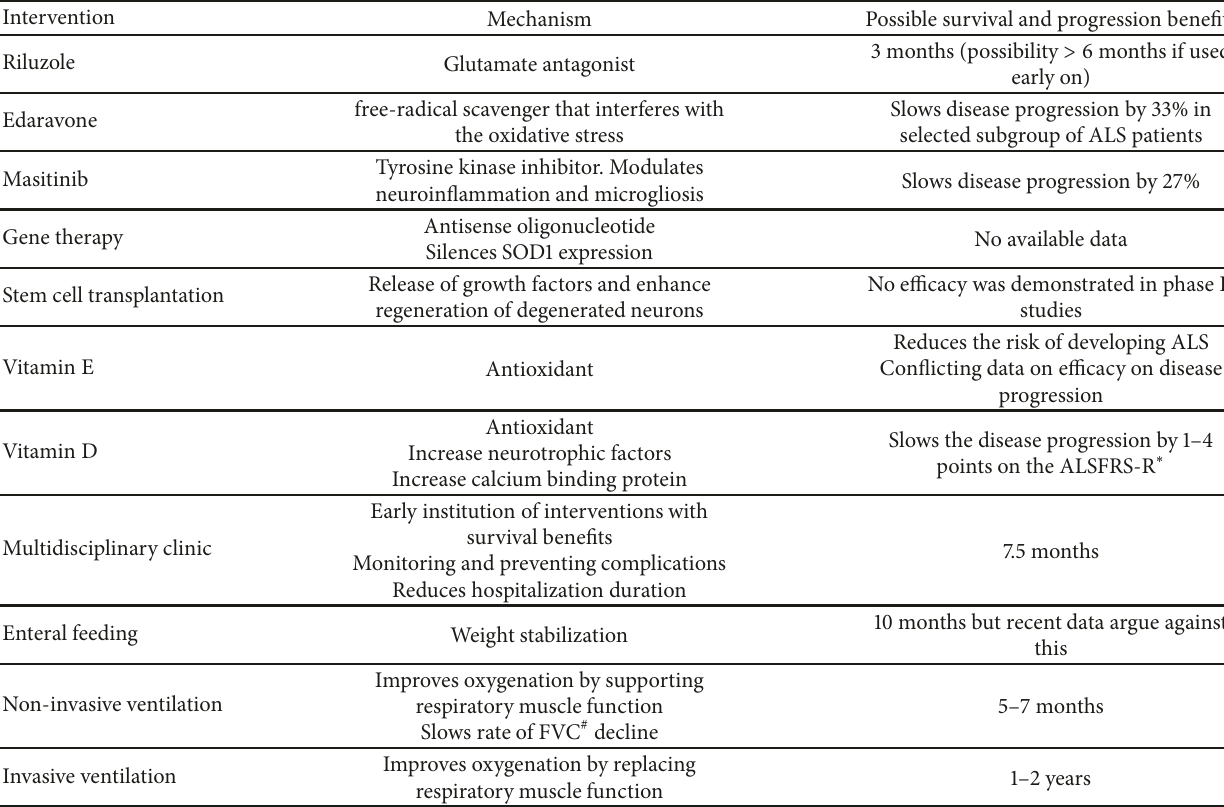
Table 1: Interventions that may lead to survival benefits in ALS